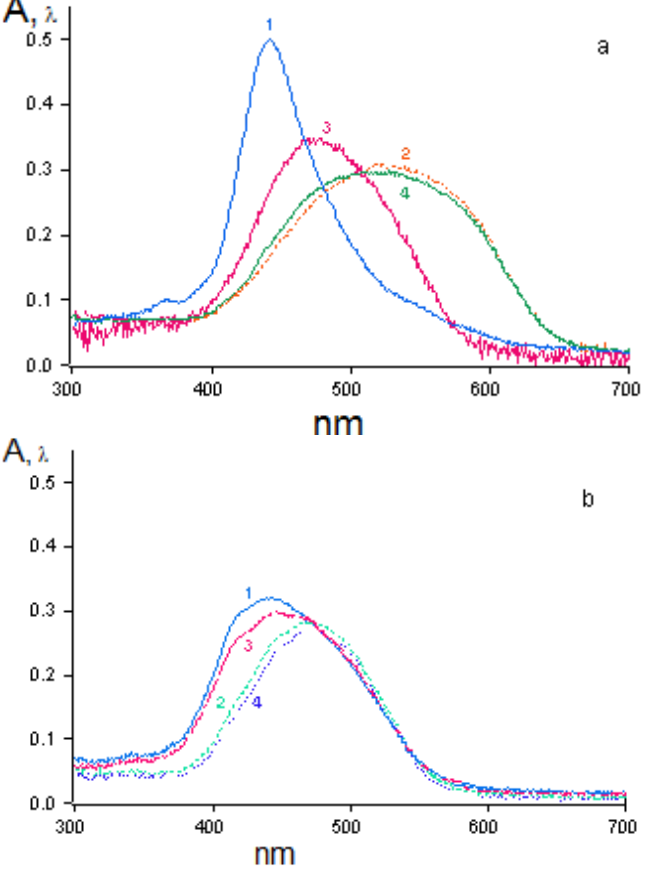
Figure 7. Absorption spectra of BDCE in monolayers on the surface of ( a ) distilled water, and ( b ) 1 mM Hg(ClO ) solutions at pressures of (1) 30 mN/m; (2) 20 mN/m; 4 2 (3) 10 mN/m; and (4) 1